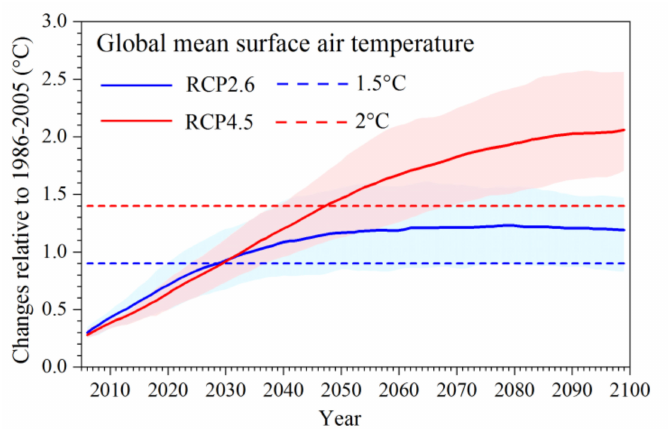
Figure 2. Projected changes in annual mean surface air temperature over the globe. Changes are relative to 1986–2005 mean, with a 20-year smoothing applied. Thick lines represented the multi-model mean, and the shaded parts showed the interquartile range of the five models. The dashed lines represented 1.5 ◦ C and 2 ◦ C global warming levels.